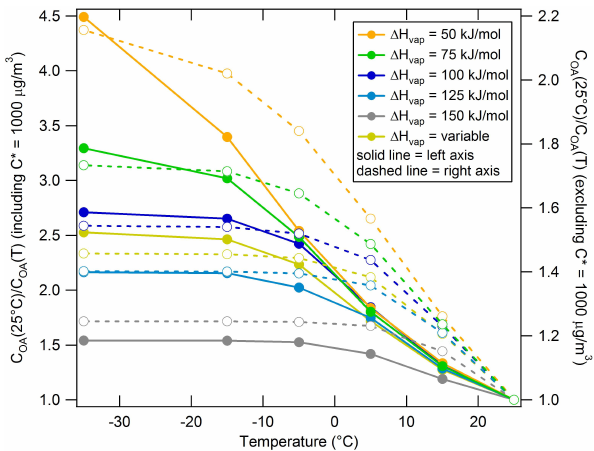
Fig. 4. The calculated increase in C OA upon cooling from 25 ◦ C (without dilution) is shown for each of the assumed 1H vap . Relative values, i.e. C OA (25 ◦ C)/ C OA (T ) , are shown when the C ∗ =1000µg/m 3 bin is included (left axis) and excluded (right axis).